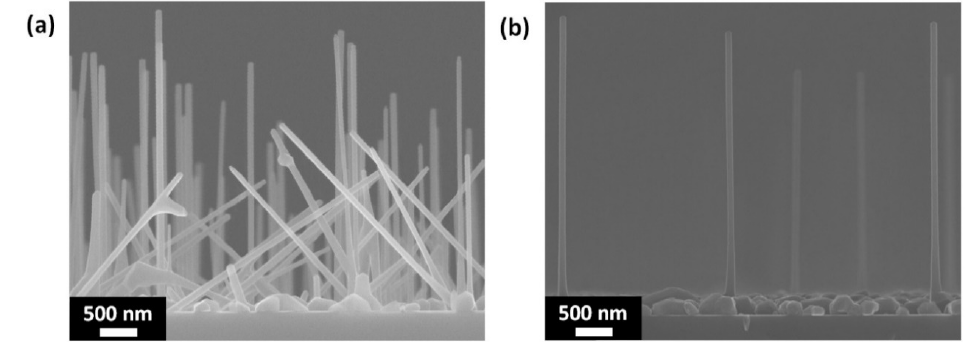
Figure 2. Typical SEM images of GaAs NWs grown on SiO x /Si(111) substrate: ( a ) without In pre-treatment; ( b ) with In pre-treatment.